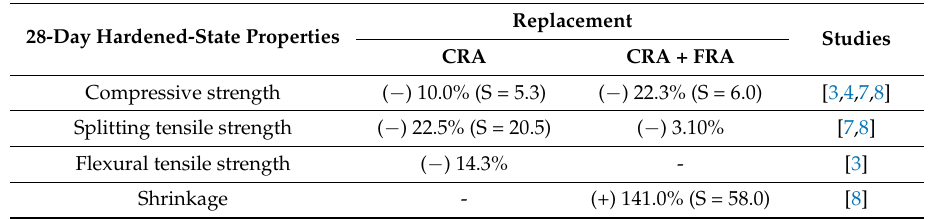
Table 2. CRA and FRA’s influence on SCC’s 28-day hardened-state performance in previous research.